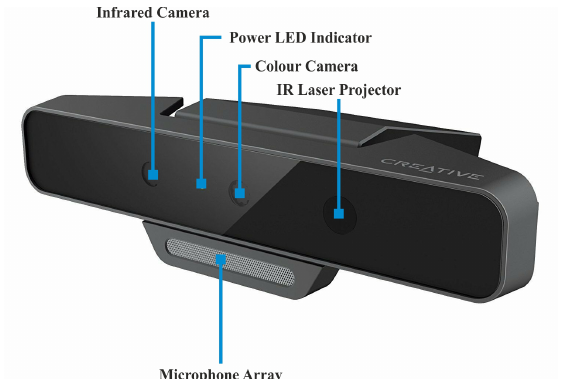
Figure 2. Intel RealSense sr300 sensor [own work based on https://us.creative.com/p/web-cameras/ blasterx-senz3d].